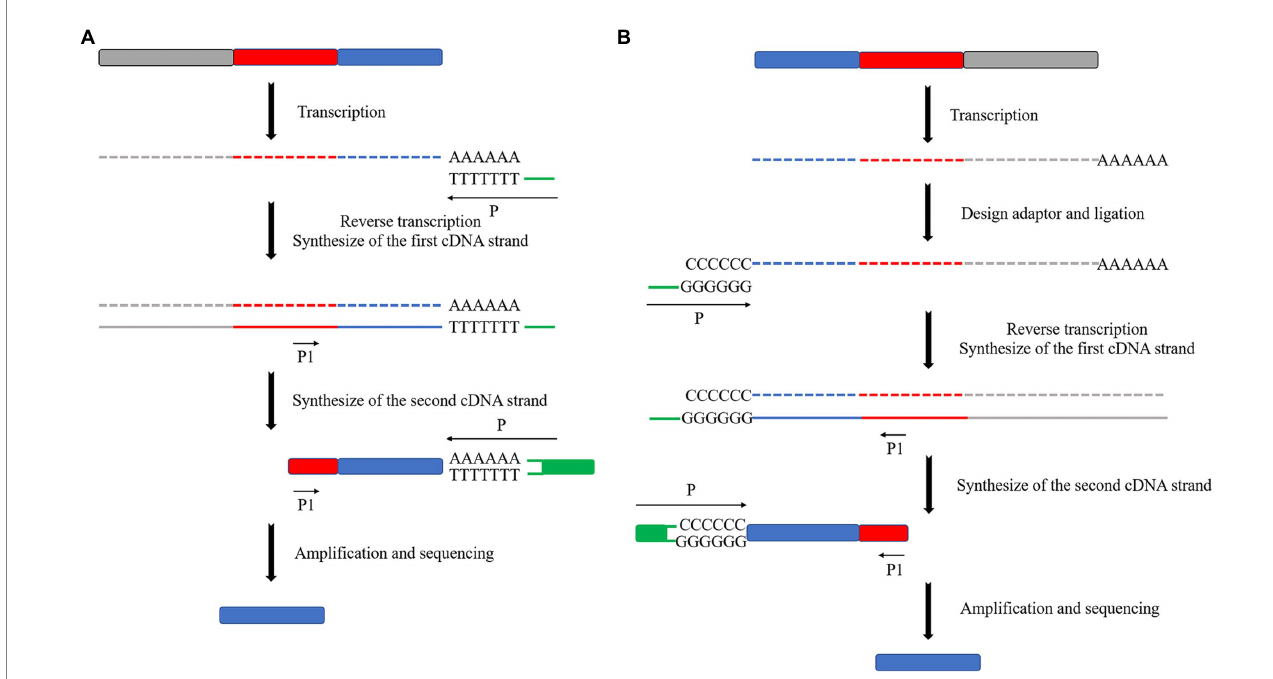
FIGURE 5 Schematic diagram of the principle of RACE in eukaryotes. (A) 3 ′ end RACE utilizes the post-transcriptional poly(A) tail structure of mRNA first to reverse transcribe the first cDNA strand containing the transposon sequence and then synthesize the second cDNA strand by using specific primers on the transposon sequence. (B) 5 ′ end RACE is performed by ligating a poly(C) tail structure after transcription. Then, the same operation as 3 ′ end RACE is performed.